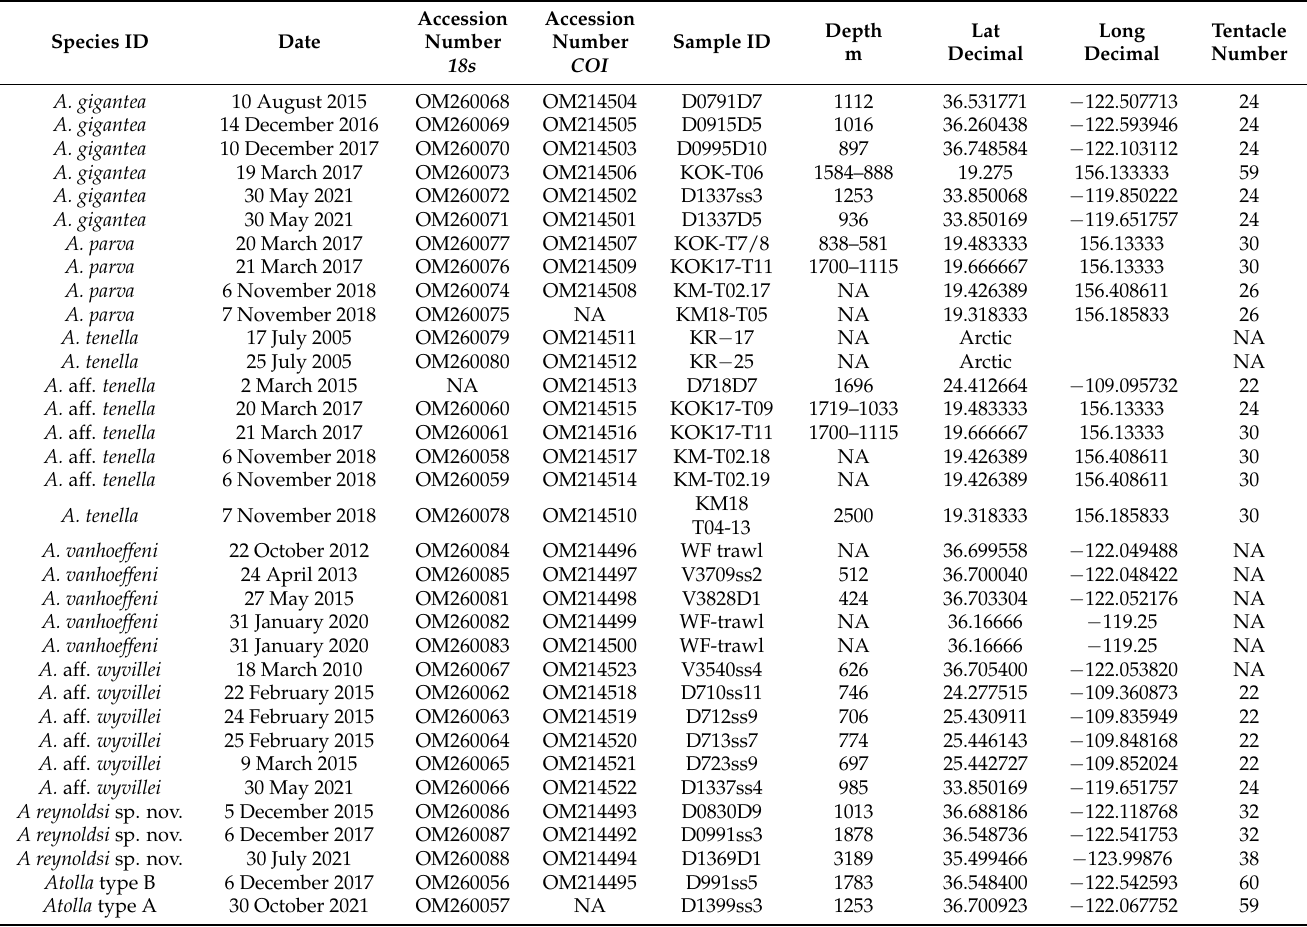
Table 1. Physical measurements and accession numbers for the collected Atolla specimens used for sequencing COI and 18S